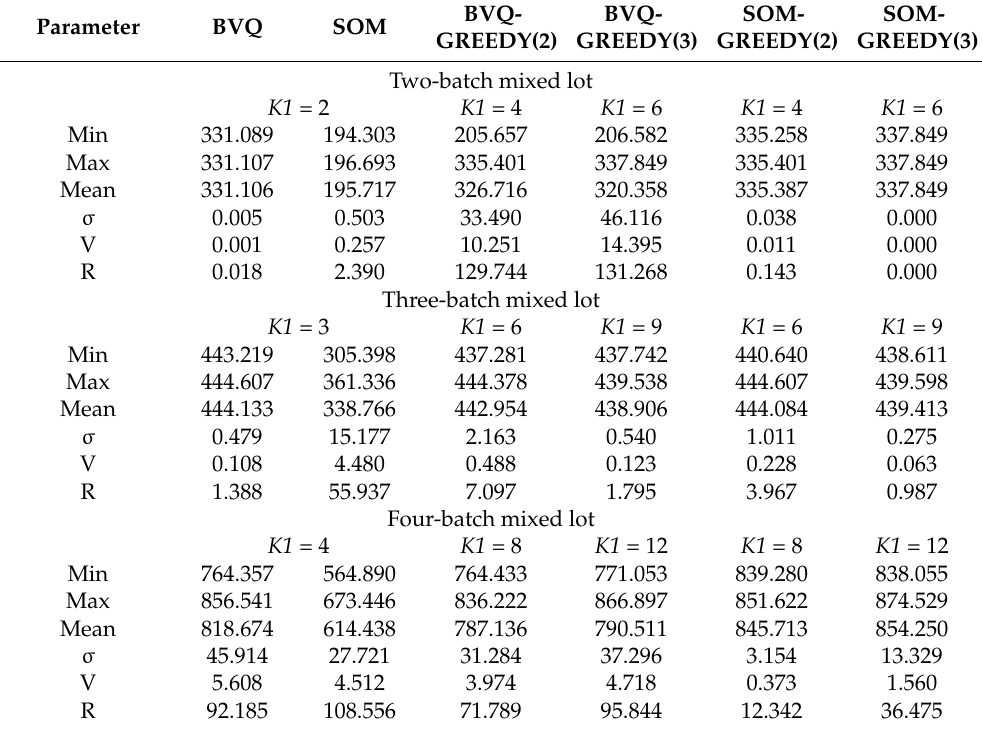
Table A12. Objective function value summarized after 30 attempts (Mahalanobis distance, initializa- tion by